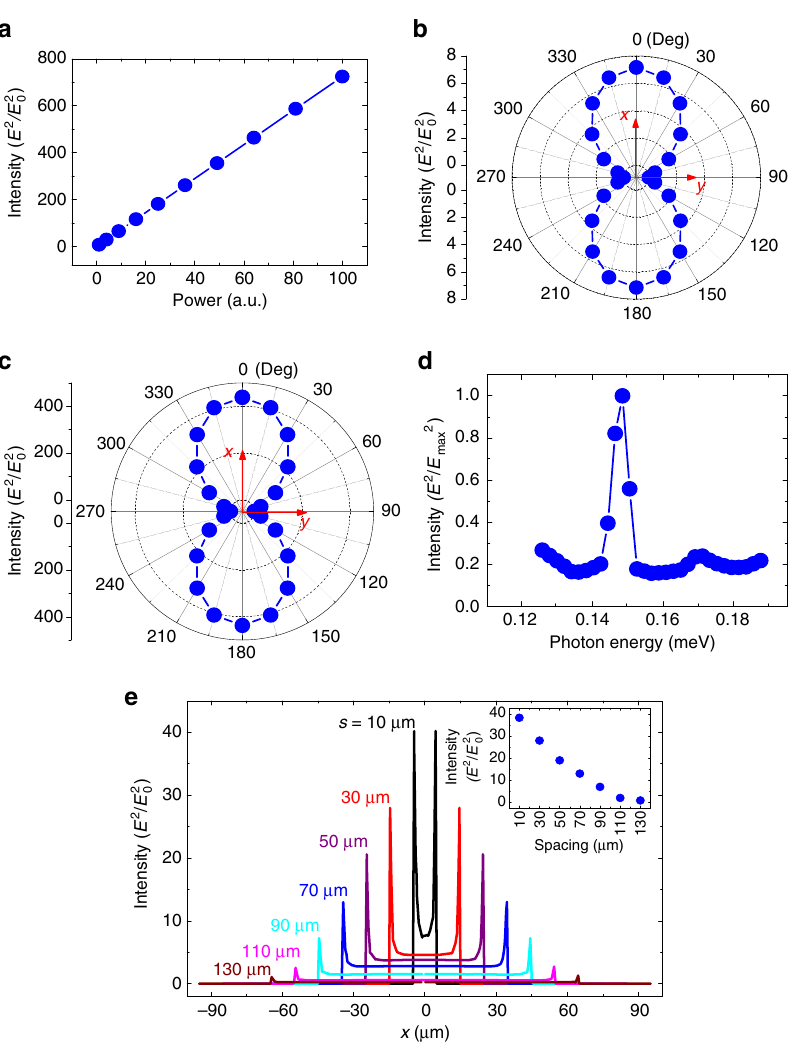
Fig. 3 Numerical simulations for the antenna-assisted subwavelength Au – InSb – Au structure. a Localized surface plasmon polariton (SPP) intensity ( E 2 / 2 ) of the structure as a function of incident power. b SPP intensity of the structure at different polarization angles for incident 0.151 meV photons. c SPP E 0 intensity of the air – InSb – air structure at different polarization angles for incident photons of 0.151 meV for comparison. d Normalized E 2 / E max 2 as a function of incident photon energy. e Distribution of E 2 / E 0 2 along the half width line for devices with spacings s of 10, 30, 50, 70, 90, 110, and 130 µ m. Inset: E 2 / E 0 2 as a function of s at the point ( s /2, 0,